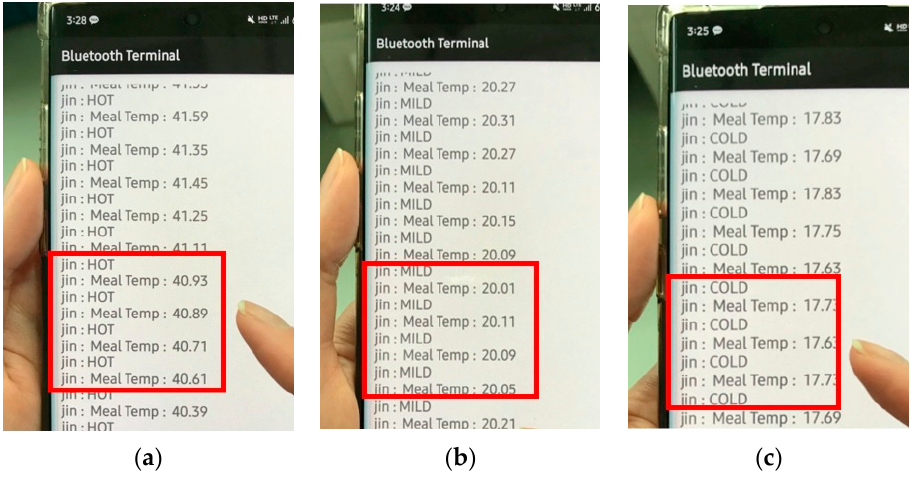
Figure 8. Wireless transfer over a mobile phone by using Bluetooth network: ( a ) hot (over 40 °C), ( b ) mild (in between), and ( c ) cold (below 20 °C) temperatures.